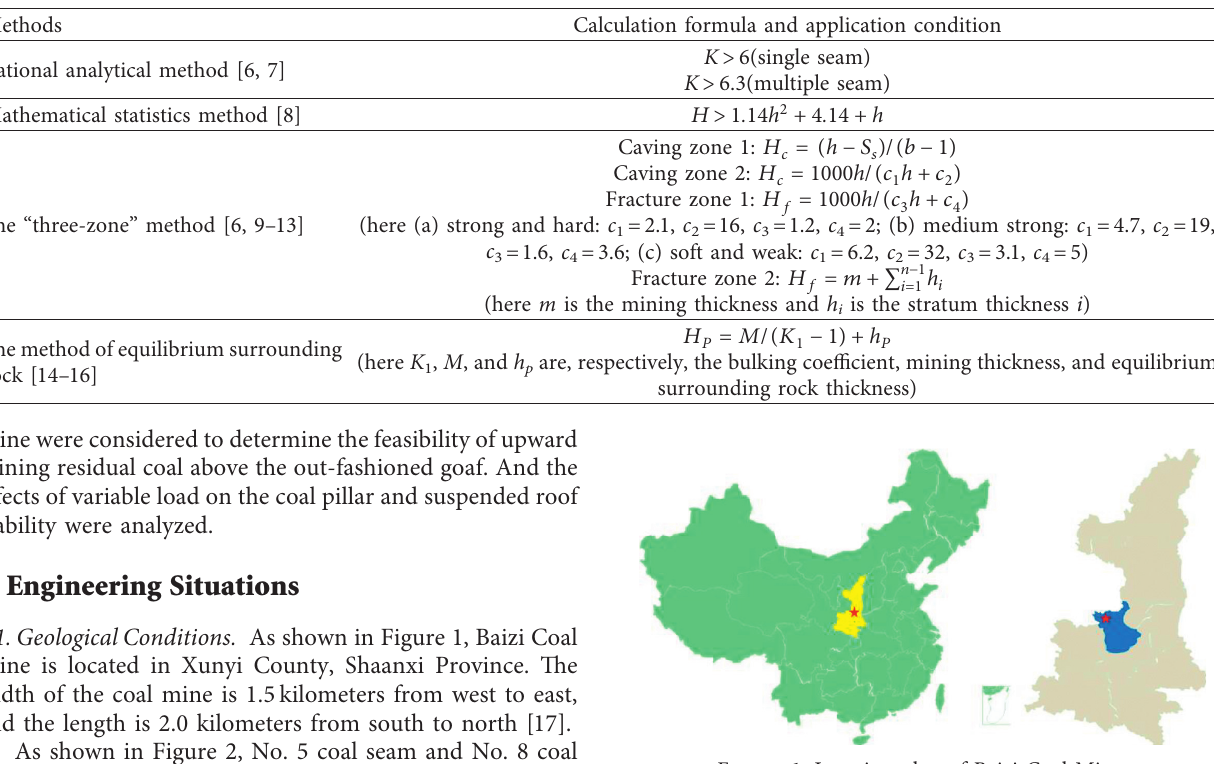
Table 1: Stability determination methods of the upward mining of longwall goaf.